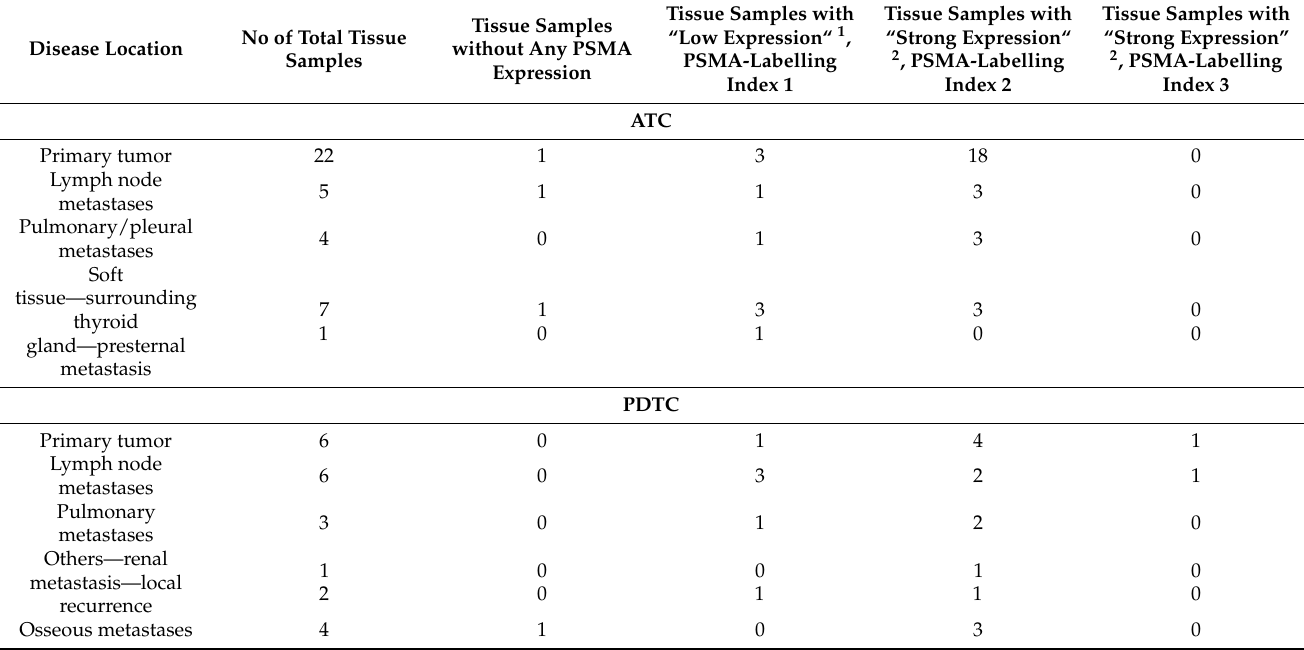
Table 5. IHC analysis: Extend of PSMA expression in tissue samples of ATC and